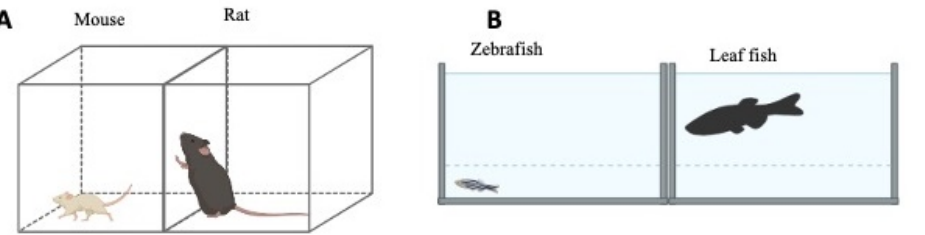
Figure 15. The predator avoidance test. ( A ) Test in mice; ( B ) test in zebrafish. Created with Bioren- der.com.